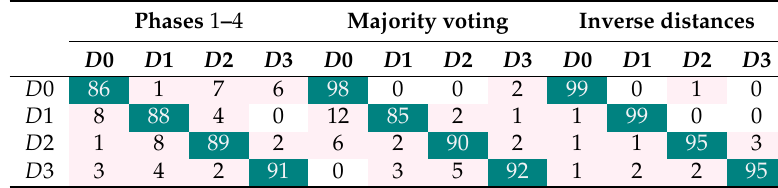
Table 8. Confusion matrix of the application of the t -SNE based damage detection and classification procedure presented in Sections 3 and 4 to the case of the aluminum plate in Scenario 3 , when the four actuation phases are used at the same time, in the time domain . Rows represent true values, while columns represent predicted values.